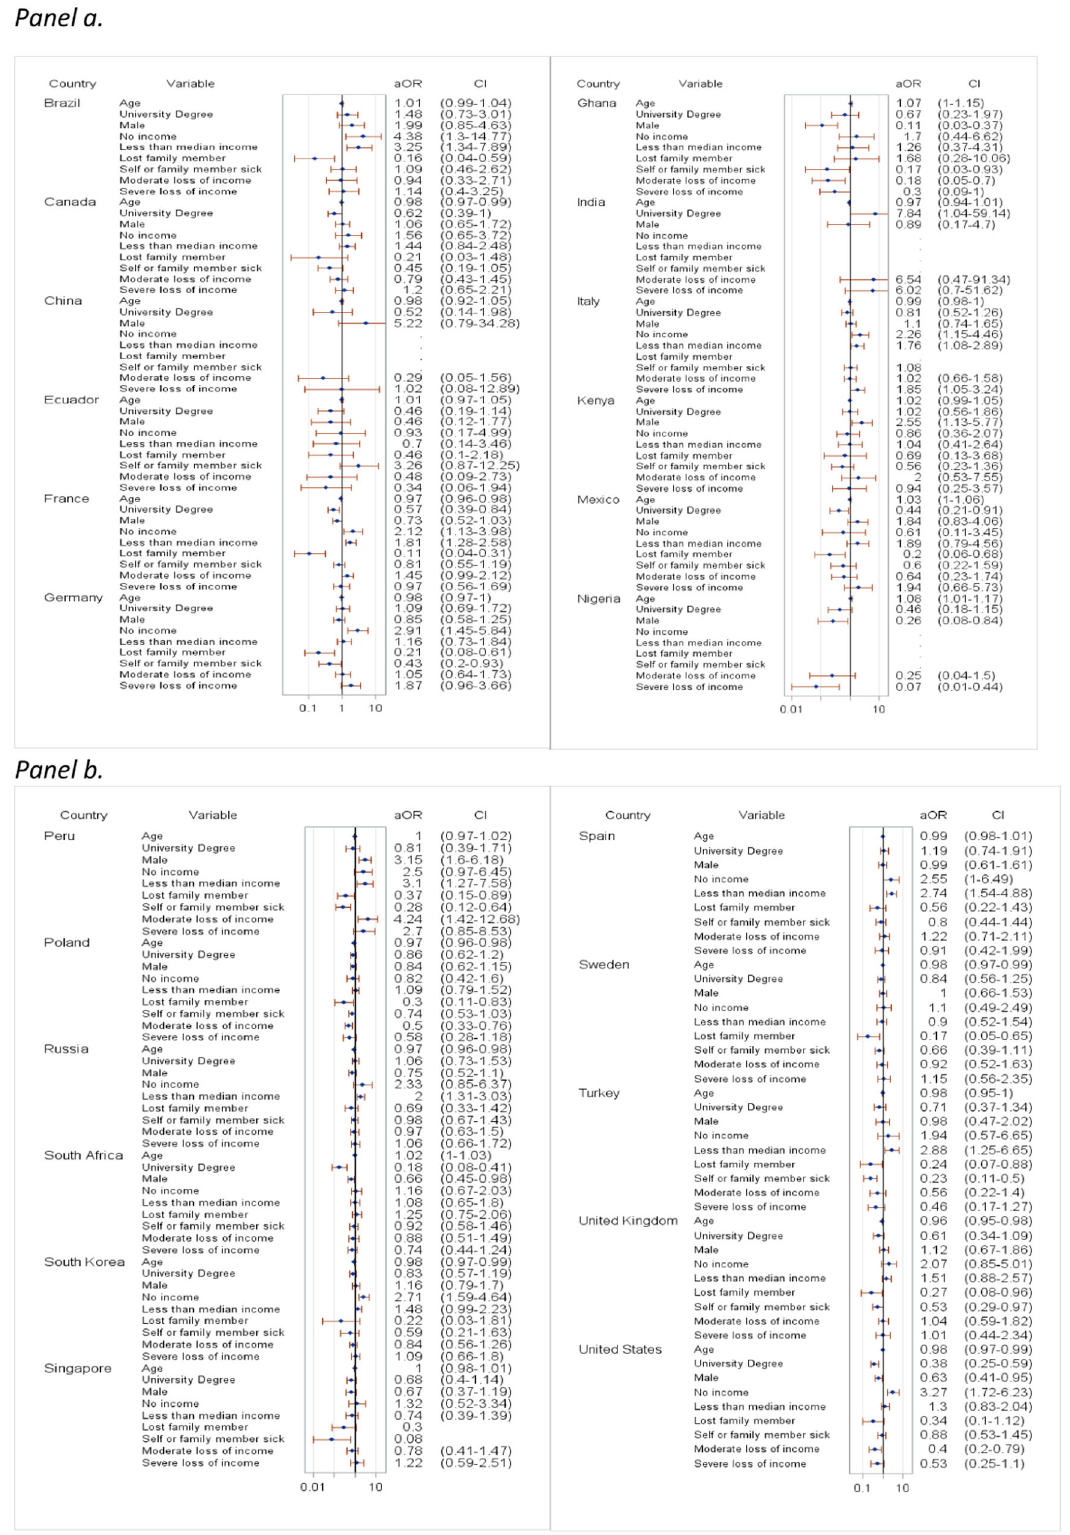
Fig. 4 Correlates of COVID-19 vaccine hesitancy with socio-demographic factors and COVID-19 experience. a Correlates in Brazil, Canada, China, Ecuador, France, Germany, Ghana, India, Italy, Kenya, Mexico, and Nigeria. b Correlates in Peru, Poland, Russia, South Africa, South Korea, Singapore, Spain, Sweden, Turkey, the United Kingdom, and the United States. a , b Adjusted odds ratios (aOR) and 95% CI error bars (log scale) from weighted multivariable logistic regression; reference categories: Female, No university degree, More than median income, No COVID-19 sickness/death, No loss of